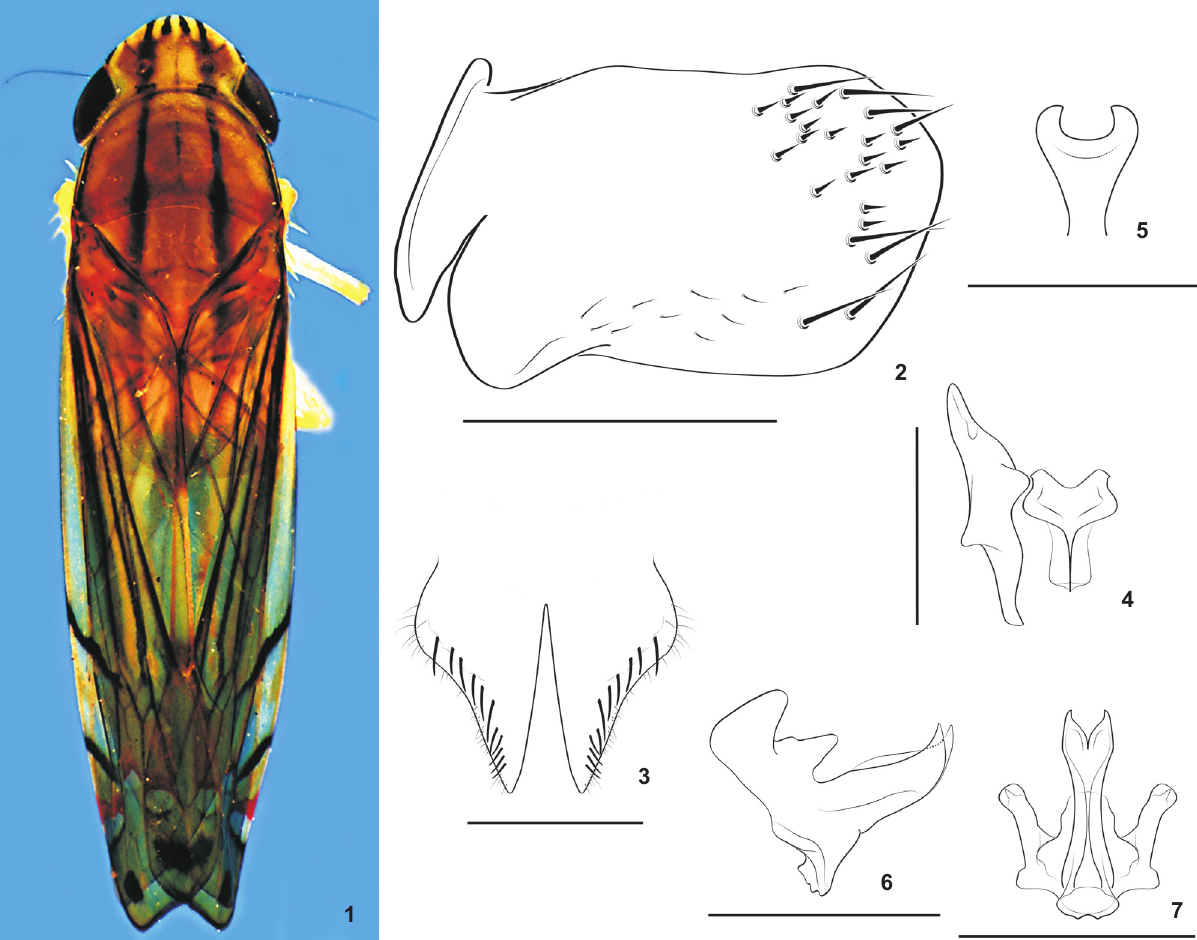
view; (4) connective and style, dorsal view; (5) paraphysis, posterior view; (6) aedeagus, lateral view; (7) aedeagus, caudal view. Scale bars = 0.5